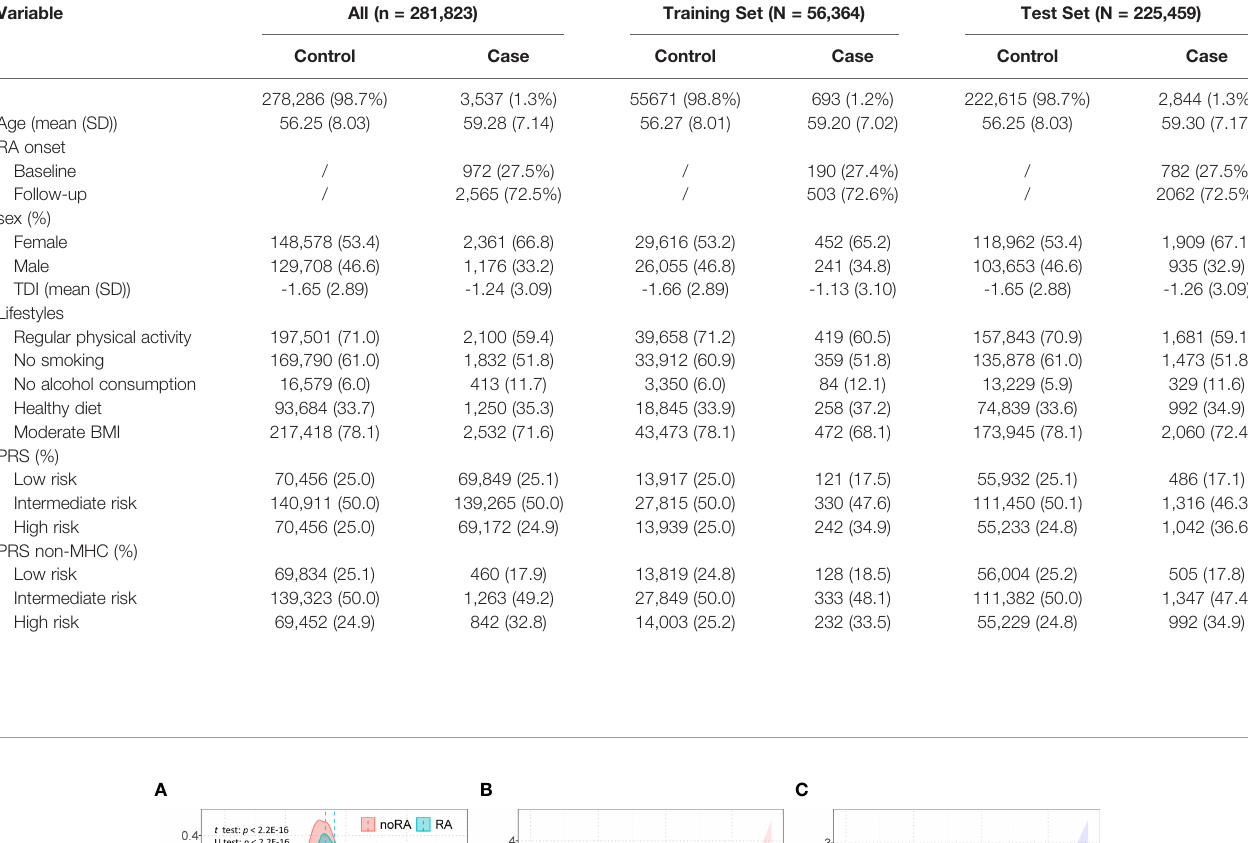
TABLE 1 | Basic characteristics of the study subjects in the UK Biobank